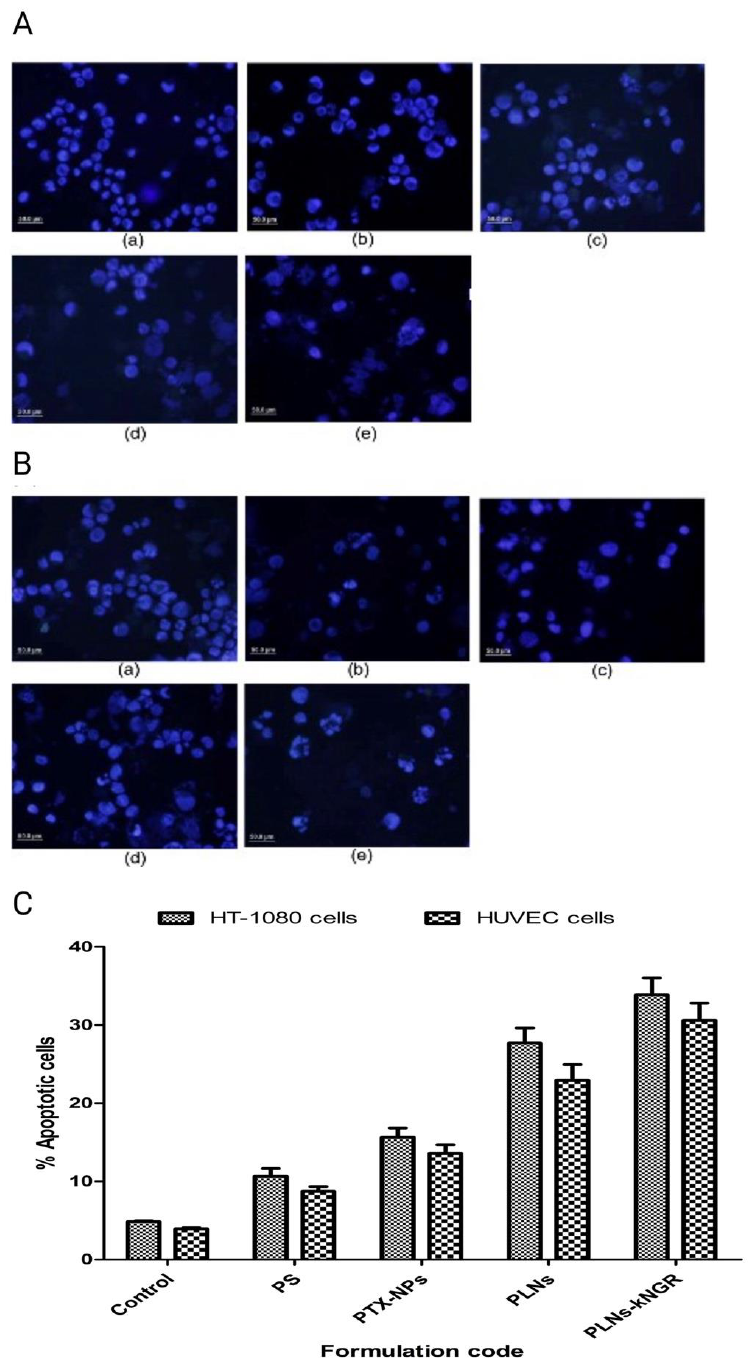
Figure 4. Influence of PTX and PTX-loaded NPs on nuclear morphology and apoptotic bodies formation in ( A ) HT-1080 cells and ( B ) HUVEC cells; ( a ) Untreated control cells ( b ) Cells treated with free PTX solution (PS) ( c ) PTX-NPs ( d ) PLNs ( e ) PLNs-kNGR. ( C ) Percent of apoptotic cells in HT-1080 and HUVEC cell line after 36 h treated with various formulations in the section. (Bar 50 µm).